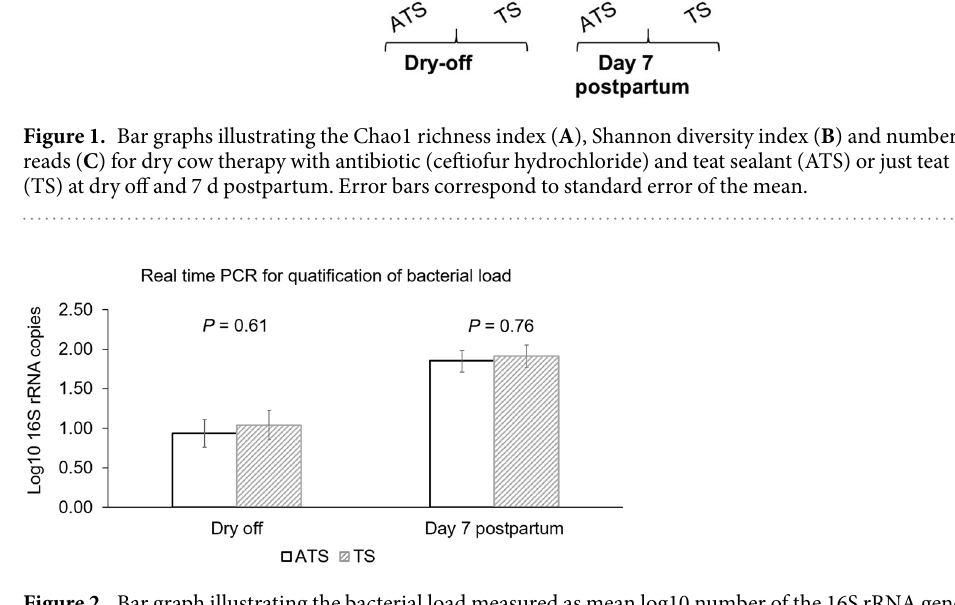
Figure 2. Bar graph illustrating the bacterial load measured as mean log10 number of the 16S rRNA gene identified in milk samples of cows enrolled either on with antibiotic (ceftiofur hydrochloride) and teat sealant (ATS) or just teat sealant (TS) at dry off and 7 days postpartum. Error bars correspond to standard error of the